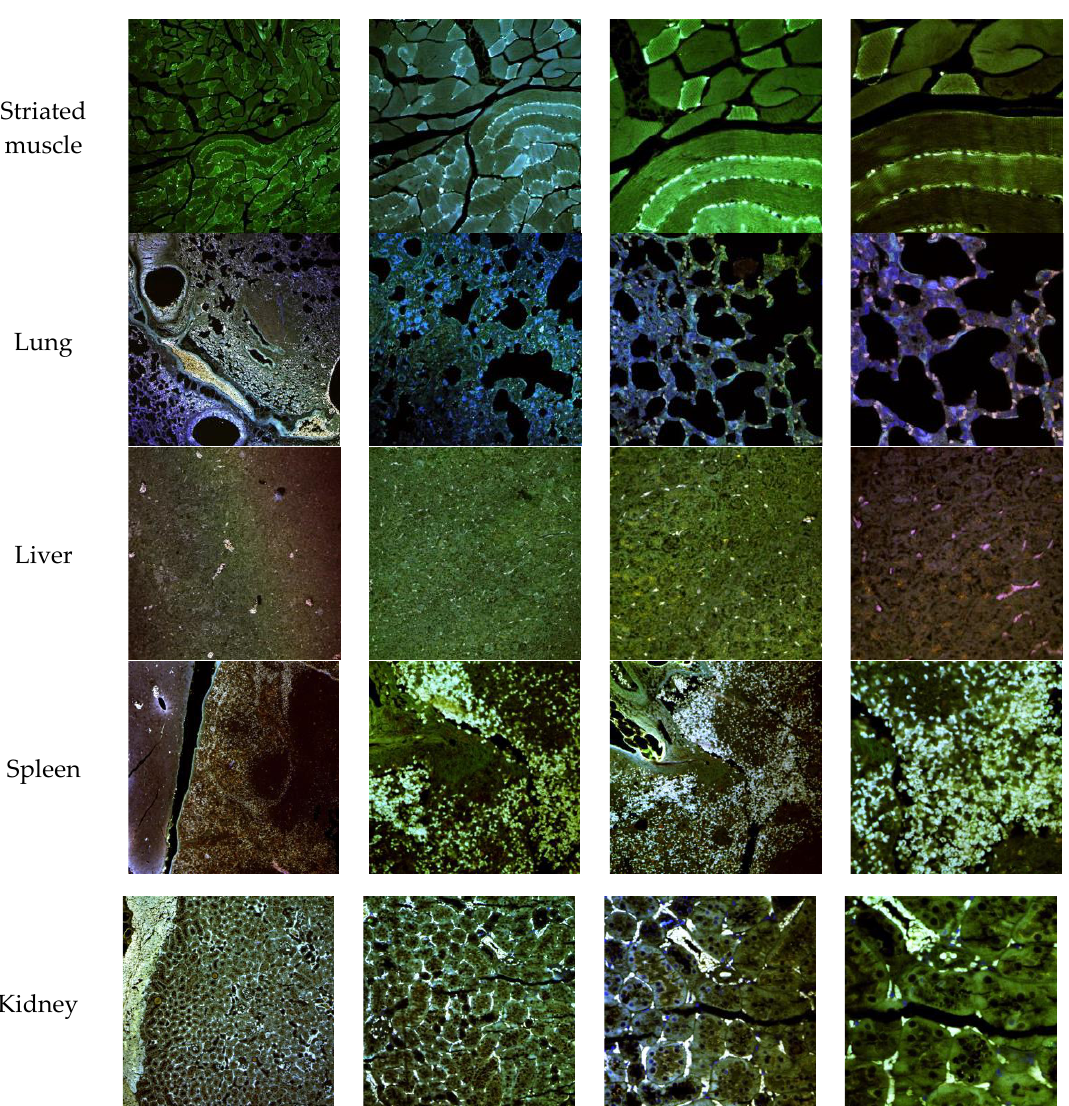
Figure 15. Confocal microscopy images of mice organs 24 h after intravenous administration of elosulfase alpha-NLC stained with DiD. From left to right: Confocal images at 10×, 20×, 40×, and 63×.